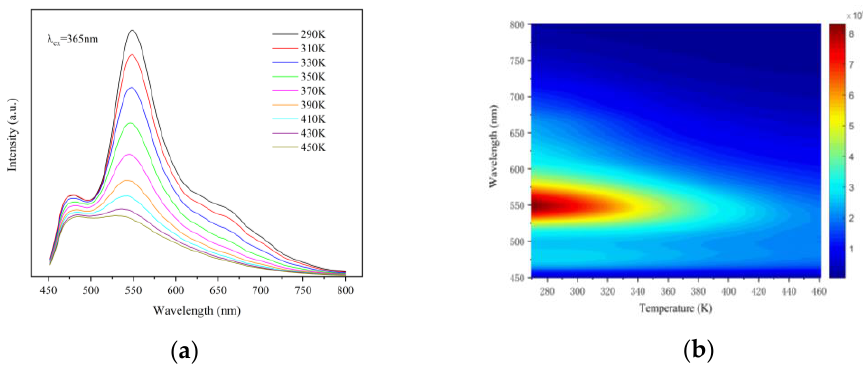
Figure 5. ( a ) The temperature-dependent emission spectra of CSO:Mn 2+ under laser excitation at 365 nm, with the temperature increasing from 290 to 450 K. ( b ) The corresponding temperature- dependent mapping of CSO:Mn 2+ under laser excitation at 365 nm.